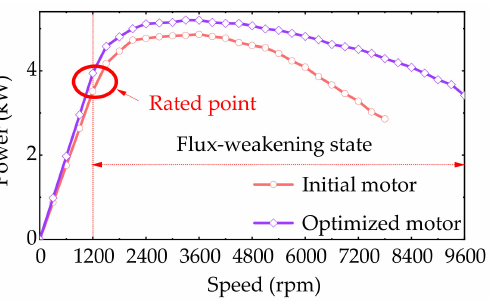
Figure 14. The power-speed curves of the initial motor and the optimized motor.